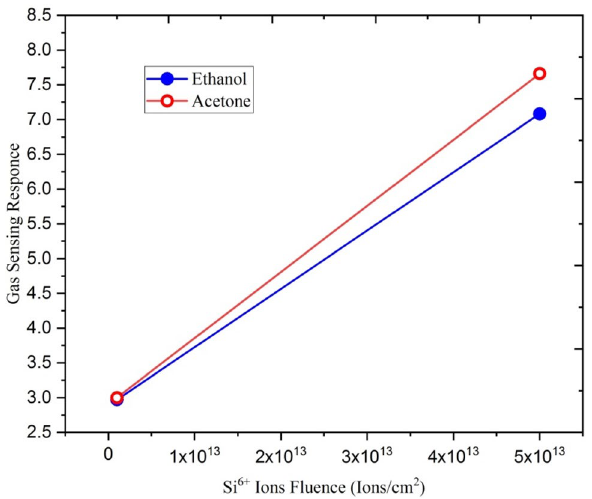
Figure 25. Variation of gas sensing response with Si 6+ ion